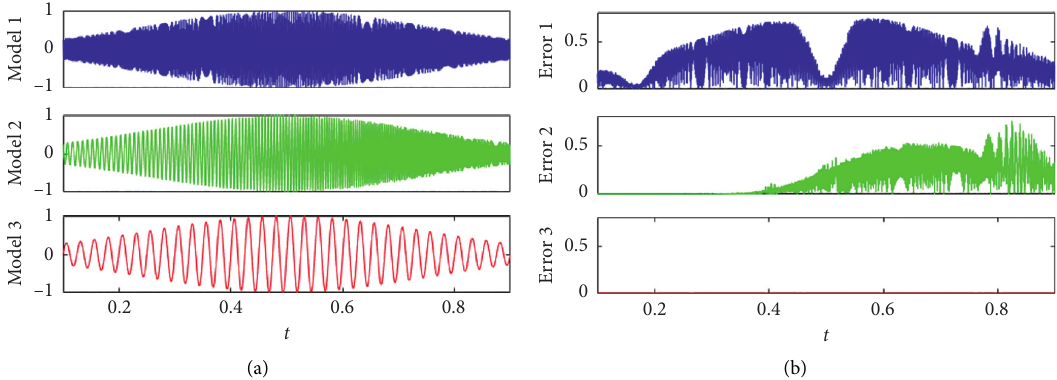
Figure 1: Three components of multicomponent and fast-varying test signal and the reconstruction error of each component based on short-time Fourier transform (STFT-) based synchrosqueezing transform (FSST). Table 1: Accuracy of mode retrieval expressed in SNR. Mode